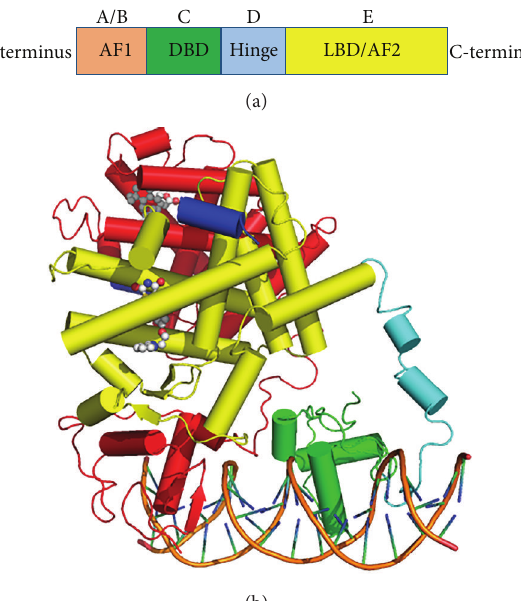
Figure 1: PPAR 𝛾 domain organization. (a) Primary structure of PPAR 𝛾 . (b) Crystal structure of the intact PPAR 𝛾 -RXR heterodimer bound to PPRE DNA with agonist ligands retinoic acid and full agonist rosiglitazone. Proteins and DNA are shown as ribbons while ligands are shown as spheres. RXR is coloured red, the PPAR 𝛾 ligand binding domain is coloured yellow, the PPAR 𝛾 DNA binding domain is coloured green, the PPAR 𝛾 hinge is coloured cyan, and the NCOA2 coactivator peptide is coloured blue. PDB: 3DZY